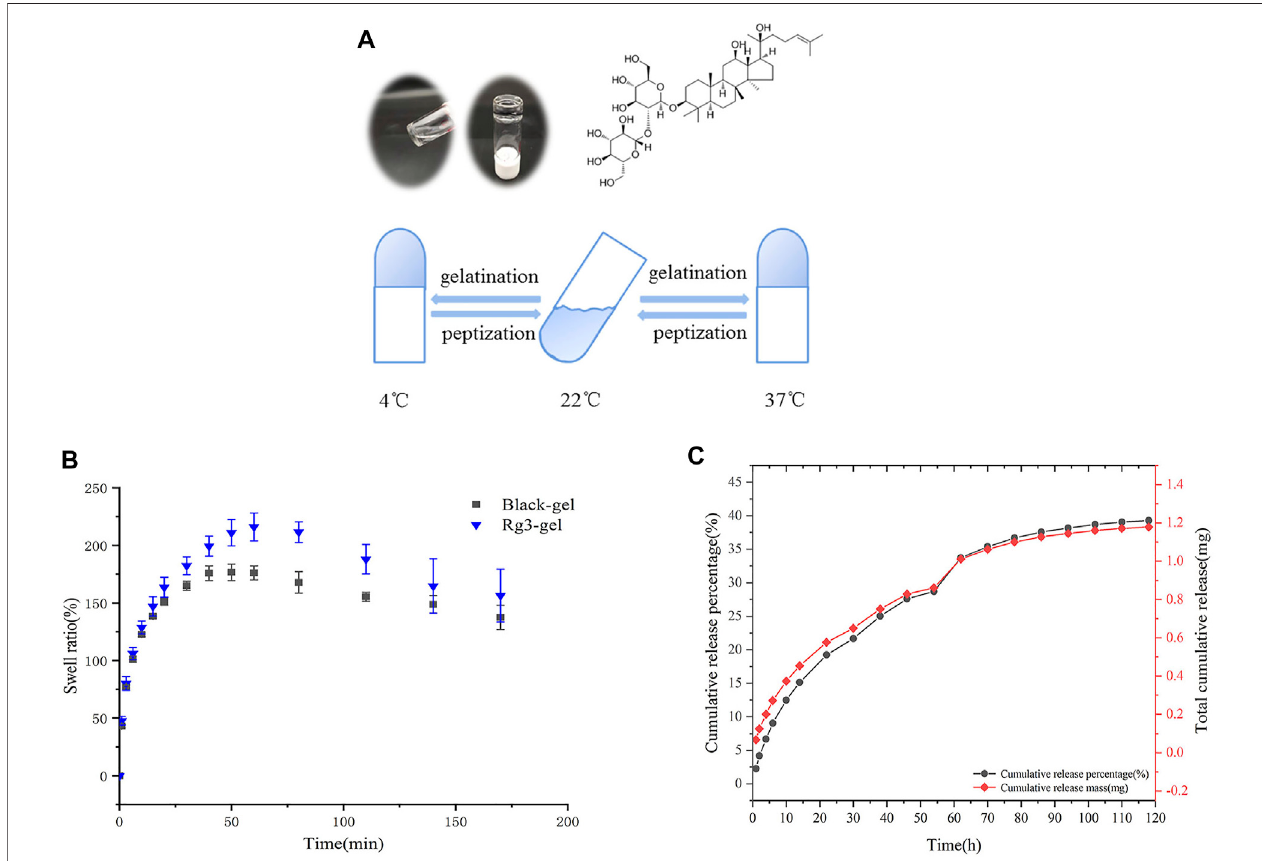
FIGURE2| Excellent propertiesofRg3-Gel. (A) Schematicand tube inversion images ofRg3-Gel withtemperature (sol – geltransition). (B) Swelling characteristics of Blank-Gel and Rg3-Gel dry samples; data represent average of triplicate experiments ±SD ( n = 3). (C) Cumulative release pro fi le of Rg3 from the hydrogel sample at 37 ° C in 0.1 (M) PBS buffer by HPLC; data represent average of triplicate release experiments ±SD ( n = 3). Antioxidant, antibacterial ability, and cytotoxicity of Rg3-Gel.